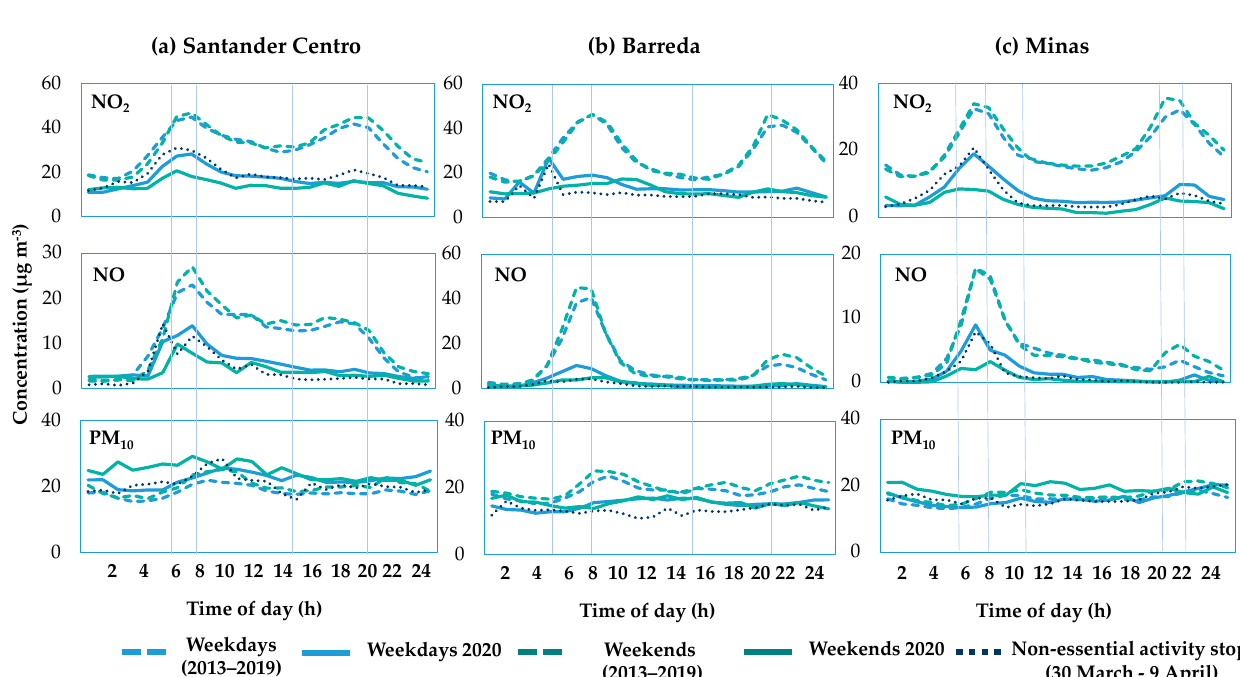
Figure 8. Daily pollutant patterns at traffic sites ( a ) Santander Centro, ( b ) Barreda, ( c ) Minas, during the 2020 lockdown and the equivalent period in the baseline (2013–2019).